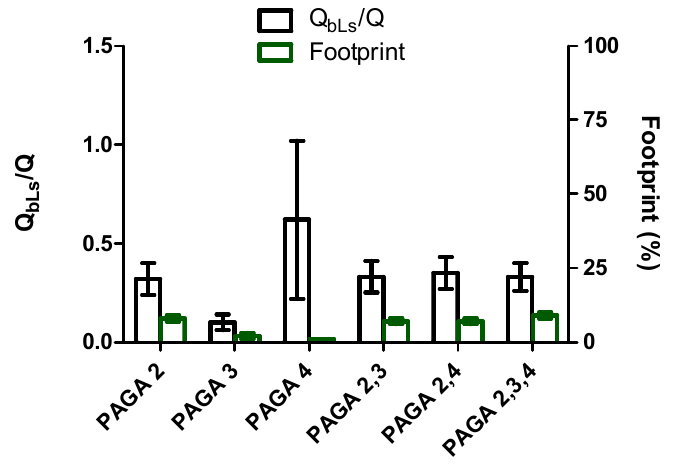
Figure 8. Accuracy of measured emission Q combinations of vertical point concentration